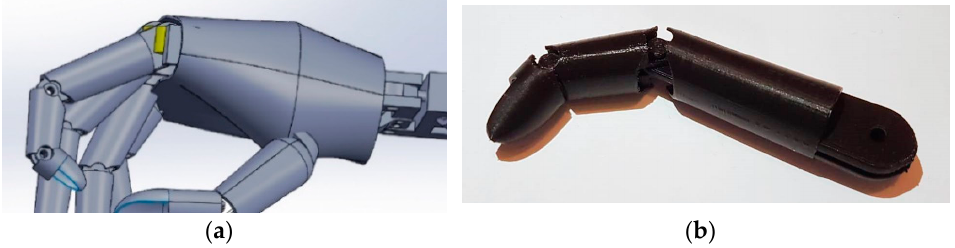
Figure 16. FDM prototype of the index finger surface. ( a ) 3D model, ( b ) FDM prototype. The 3D model to be prototyped, conventionally named, 2-FPRINT, is presented in Figure 17.